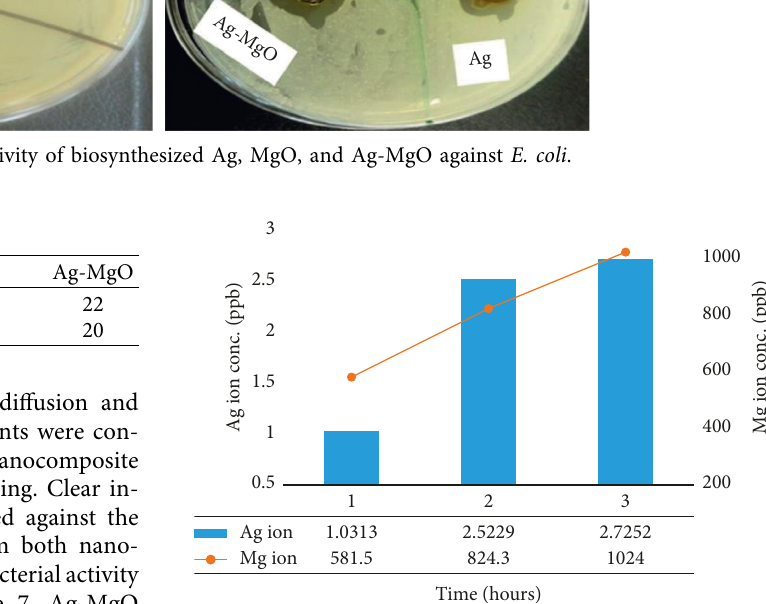
Figure 8: Time-dependent metal ions release from biosynthesized Ag-MgO